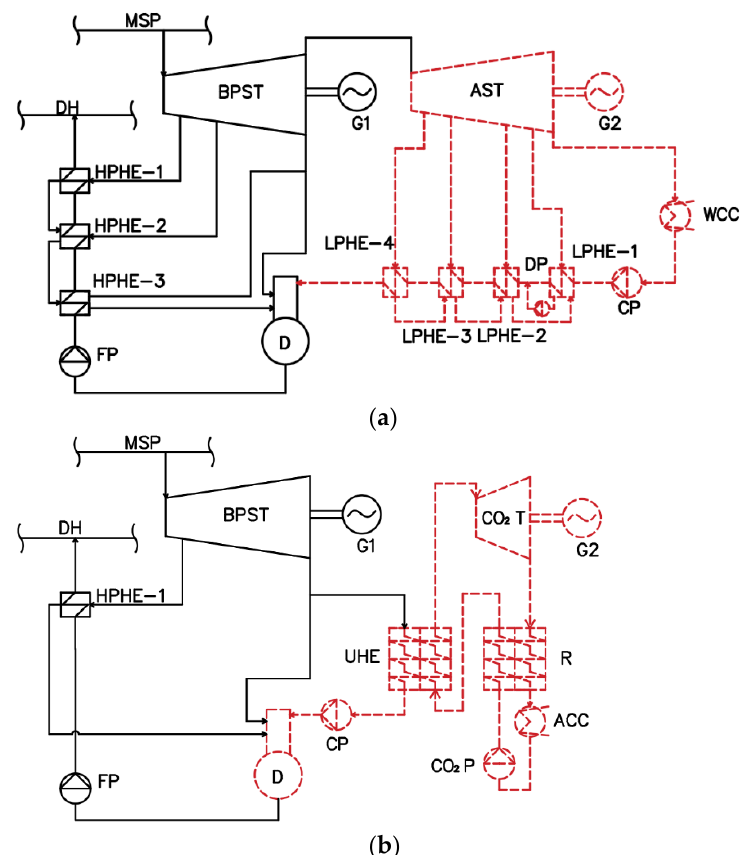
Figure 2. Prospective methods for BPST power unit modernization. ( a ) AST superstructure (Case 2a): AST—accessory steam turbine; G2—generator; WCC—water-cooled cooler; LPHE-1,2,3,4—low-pressure heat exchangers; D—deaerator; DP—drainline pump. ( b ) CO 2 cycle superstructure (Case 2b): CO 2 T—dioxide carbon turbine; R—regenerator; ACC—air-cooled cooler; CO 2 P—dioxide carbon pump; UHE—utilization heat exchanger.